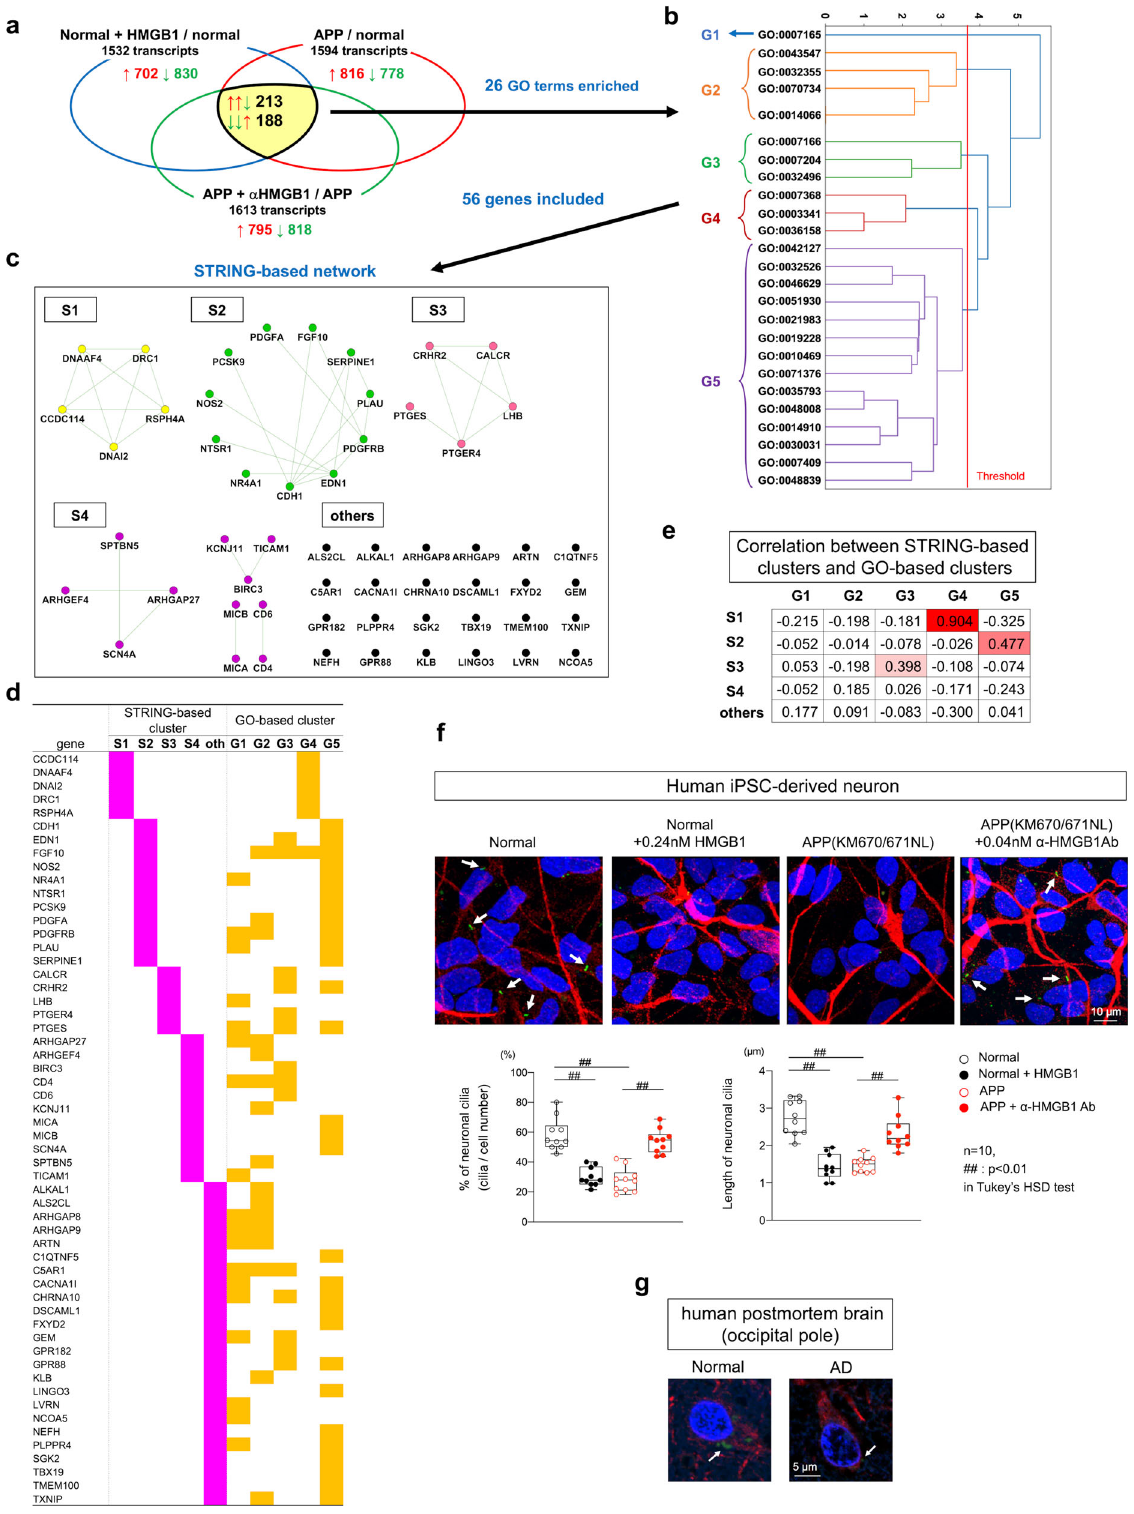
protein phosphorylation were observed with statistical signi fi - cance (Fig. 4a, b). Ectopic pSer203-tau in the downstream of MAPK pathway induces synapse instability from the early stages of frontotemporal lobar degeneration (FTLD) pathology 74 . Therefore, we examined pSer203-tau in AD pathology (Supple- mentary Fig. 12). Immunohistochemistry of 5xFAD mice after subcutaneous or intravenous injections of human control